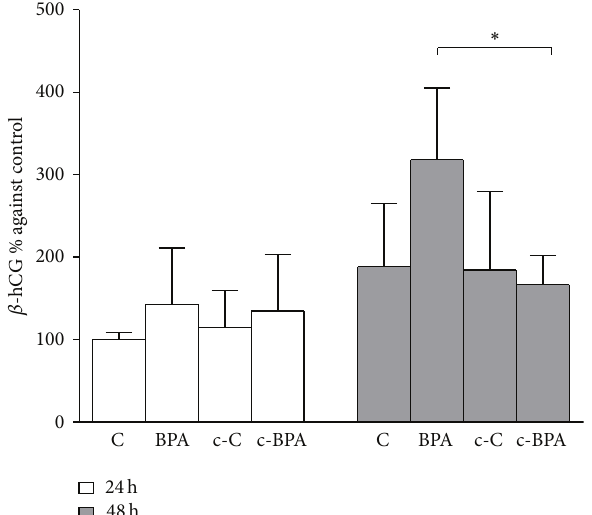
Figure 4: Concentration of 𝛽 -hCG in the culture media of explants of chorionic villi exposed to EtOH 0.1% (C), 0.5 nM BPA (BPA), or conditioned medium (diluted 1:2) from decidualized stromal cells previously exposed to vehicle (c-C) or to 1nM BPA (c-BPA). The time course lasted for 24 h (white bars) and 48h (grey bars). Values were normalized against villous explant total protein content and expressed as percentage ± SD versus C at 24 h of 𝑛 = 3 separate experiments ( ∗ 𝑃 < 0.05 BPA 48 h versus c-BPA 48 h).